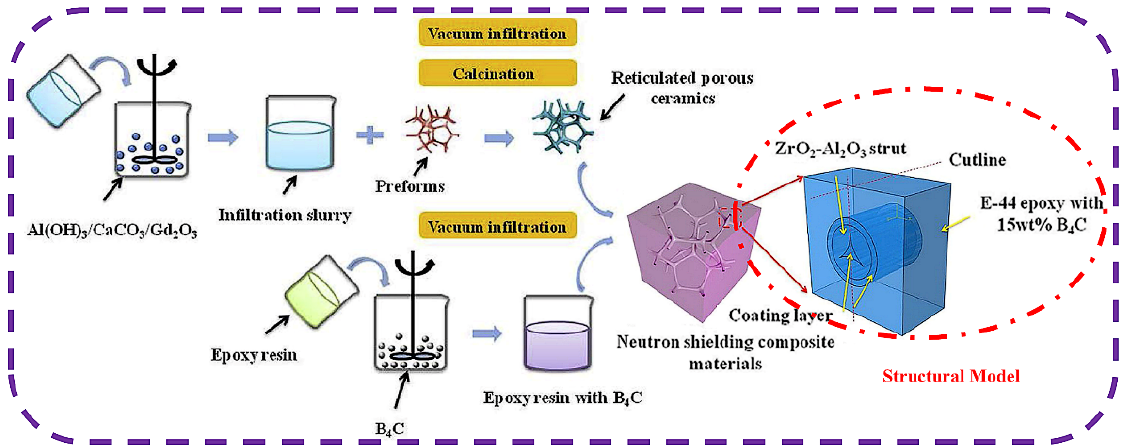
Figure 12. Schematic diagram of fabrication of three-dimensional interlaced neutron-shielding materials [68].